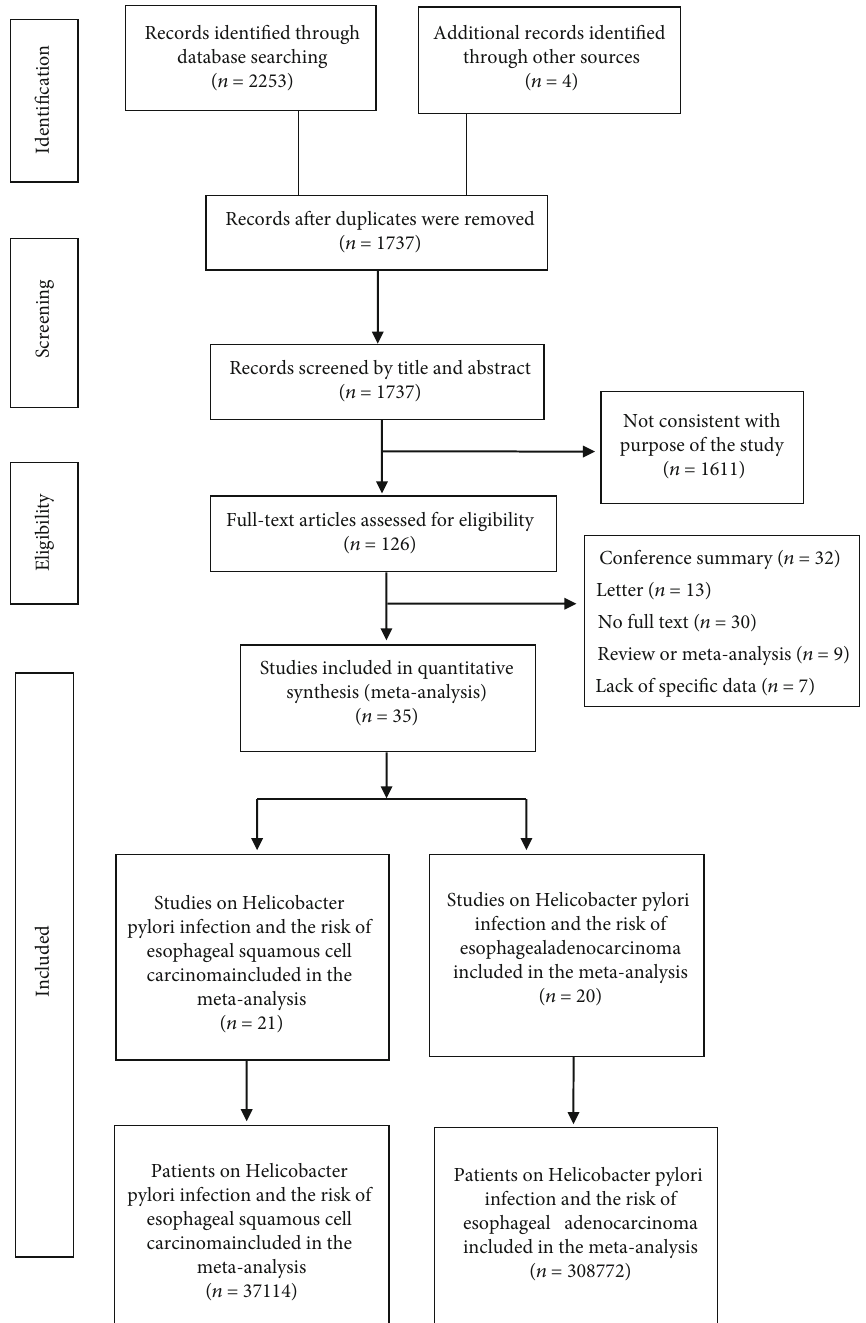
Figure 1: Flowchart showing selection of publications for